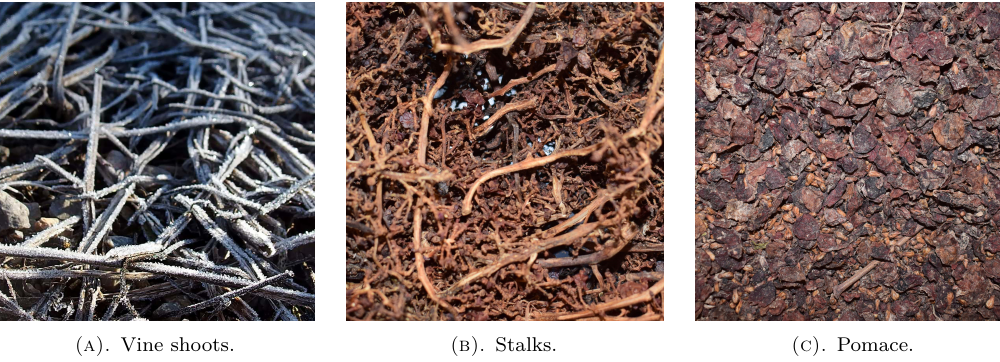
Figure 1. Three waste types of the grape production.